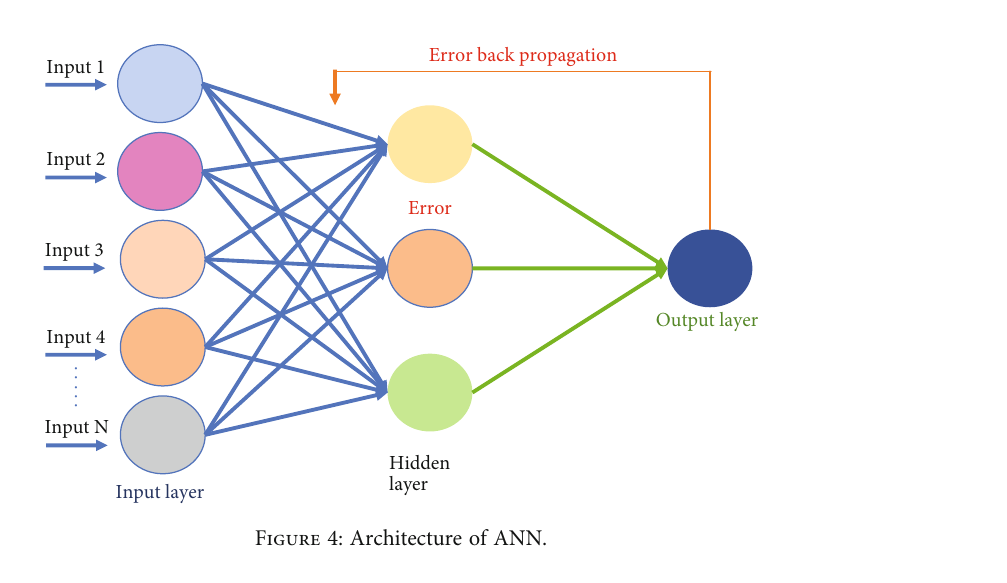
Figure 3: Random forest classi fi er architecture.